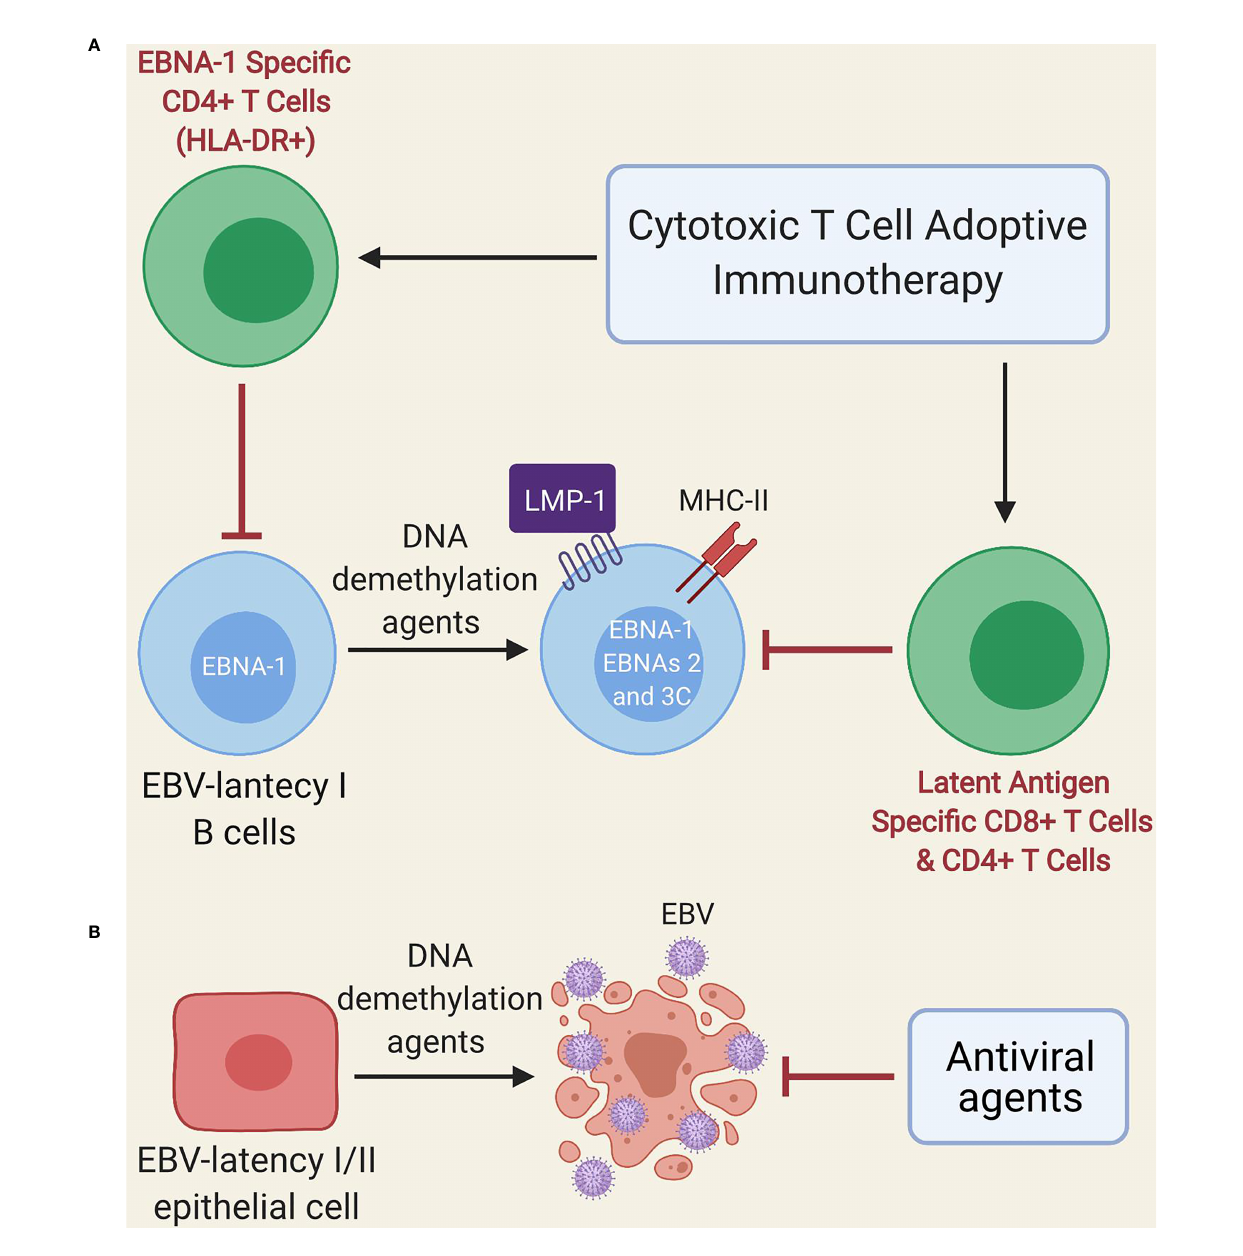
FIGURE 2 | Schematic model of treatment with DNA demethylation agents followed by adoptive immunotherapy of EBV-speci fi c T cells. (A) Administration of low- dose DNA demethylation agents (e.g. decitabine) restores the expression of MHC class II molecules and induces expression of LMP1, EBNA-2 and EBNA-3C in EBV-latency I B cells, improving the recognition of these cells by EBV-speci fi c T cells (either autogenous or after adoptive immunotherapy). EBNA-1-speci fi c CD4 T cells can only recognize latent I cells exhibiting EBNA-1 in MHC class II molecules since EBNA-1 is poorly immunogenic. (B) DNA demethylation agents (e.g. decitabine) induce lytic infection and apoptosis in EBV-transformed epithelial cells. Antiviral agents prevent viral